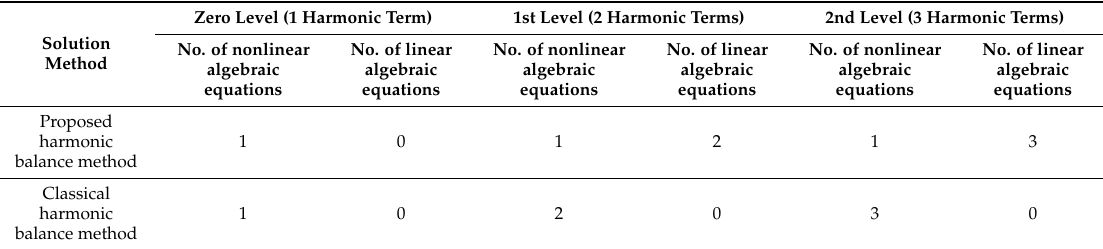
Table 1. Numbers of equations for the cubic nonlinear undamped beam